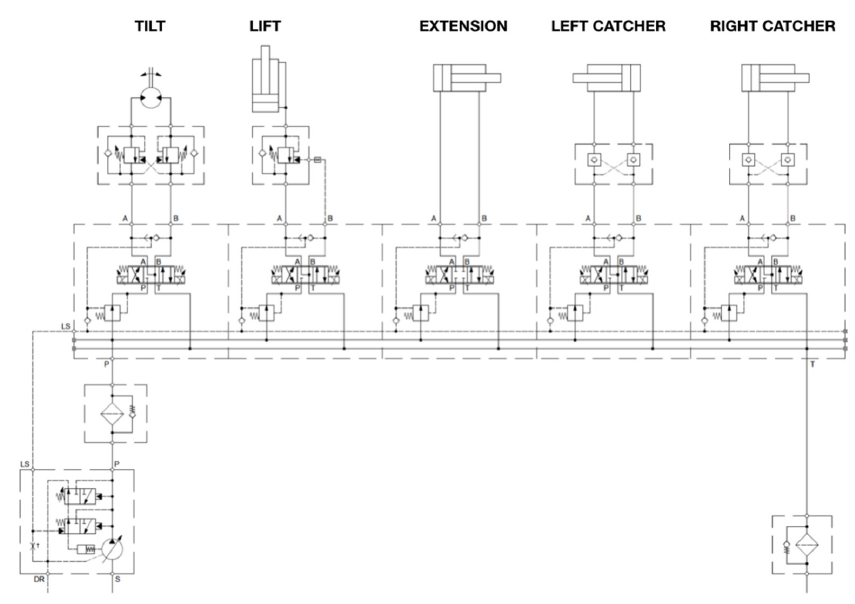
Figure 2. Hydraulic circuit. Only some actuators are shown.